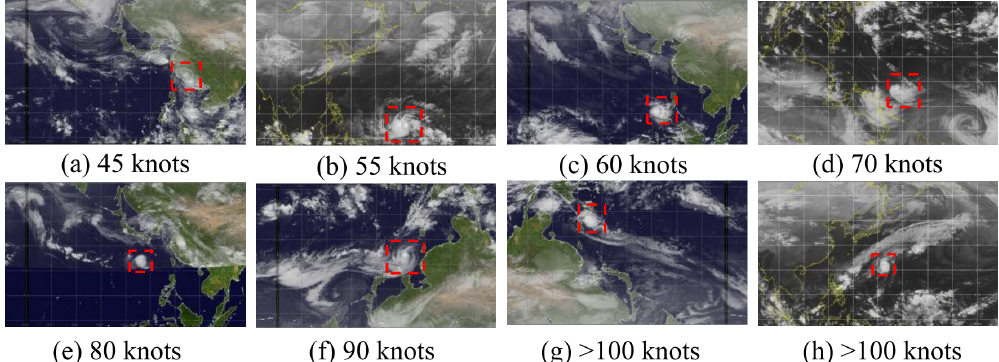
Figure 19. TC (demarcated by a red rectangle) images misjudged as non-TC